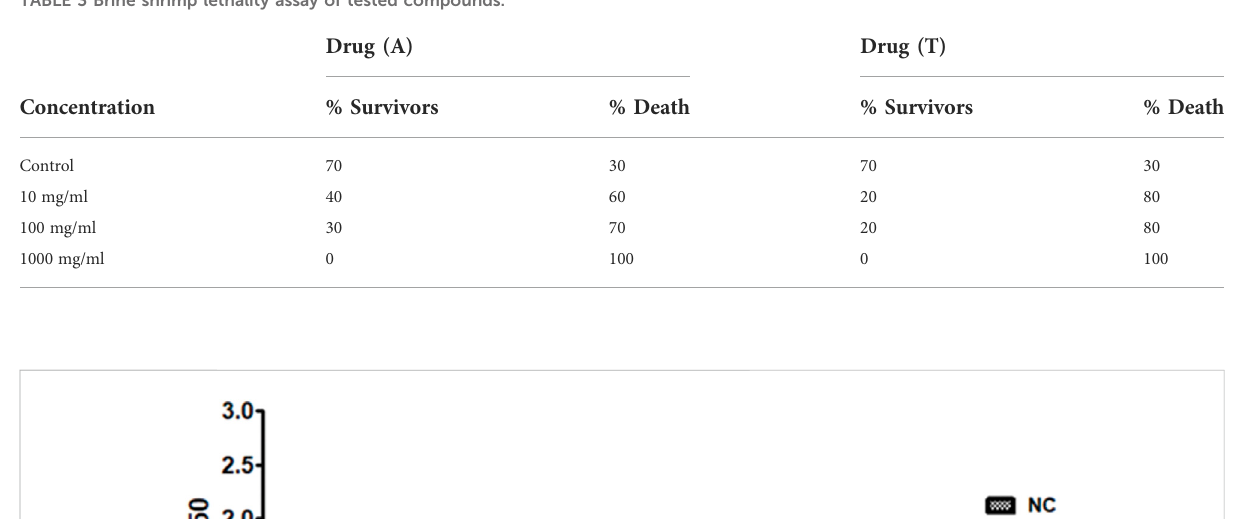
TABLE 3 Brine shrimp lethality assay of tested compounds.